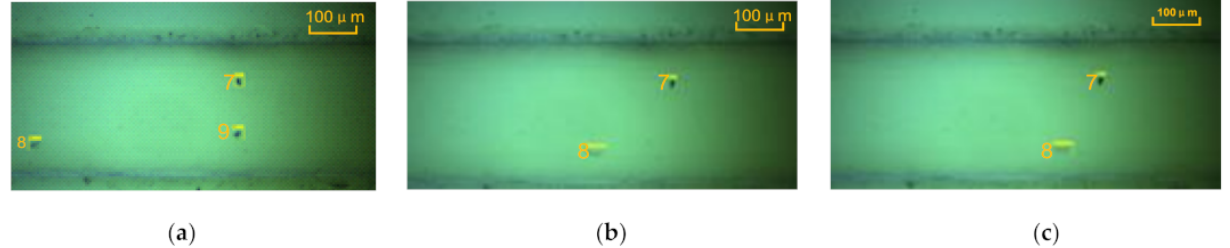
Figure 5. Images of particles #7 and #8: ( a ) frame #1, ( b ) frame #5, and ( c ) frame #6.